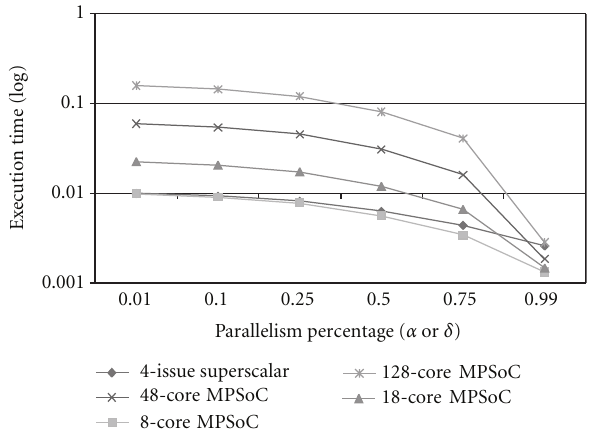
Figure 1: Multiprocessor system and superscalar